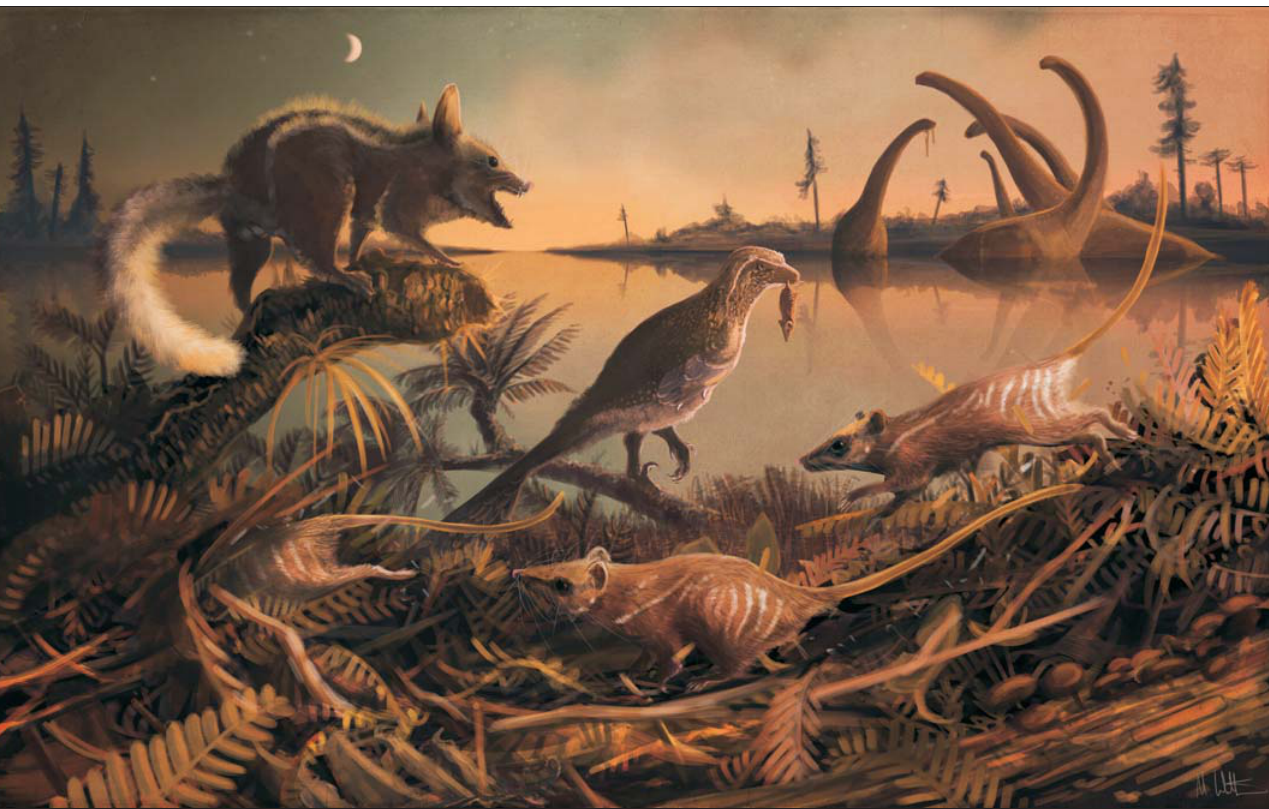
Fig. 7. Artist’s impression of the Purbeck lagoon at dusk with Durlstodon gen. nov. (left foreground), Durlstotherium gen. nov. (right and center fore- ground) and the theropod Nuthetes holding a captured Durlstotherium (centre middle distance). Artwork by Mark